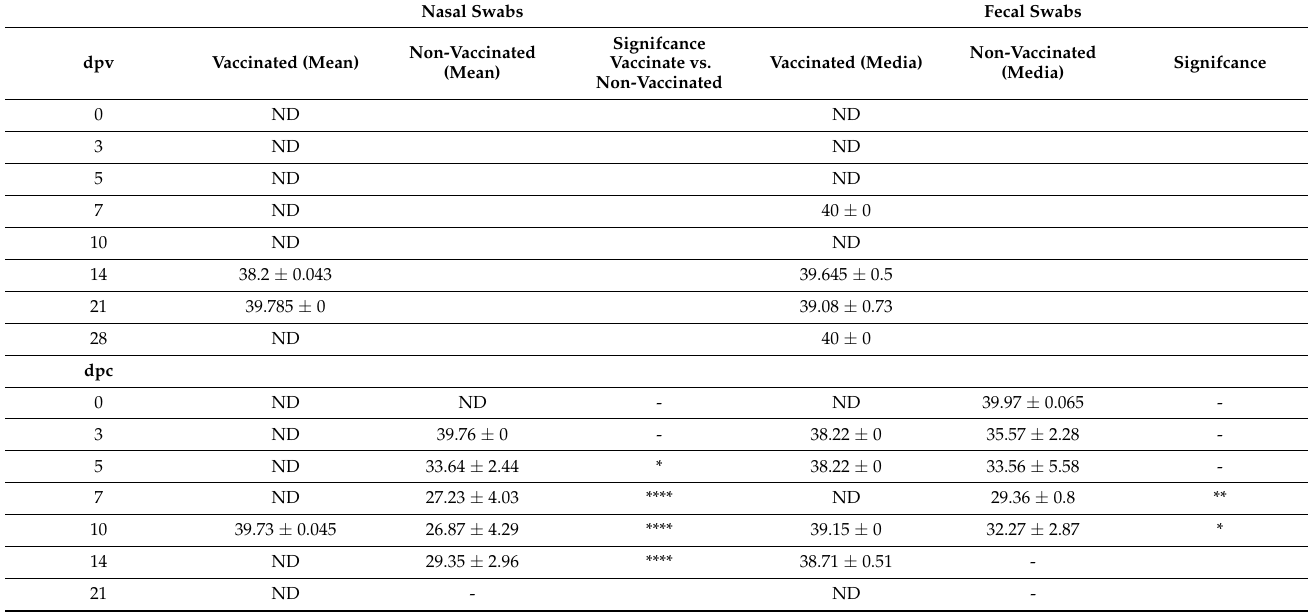
Table 3. Virus detected by qPCR in nasal and fecal swabs samples in vaccinated (#55–58) and non- vaccinated (#65–68) animals at the indicated days post vaccination (dpv) and days post challenge (dpc). Nasal Swabs Fecal Swabs